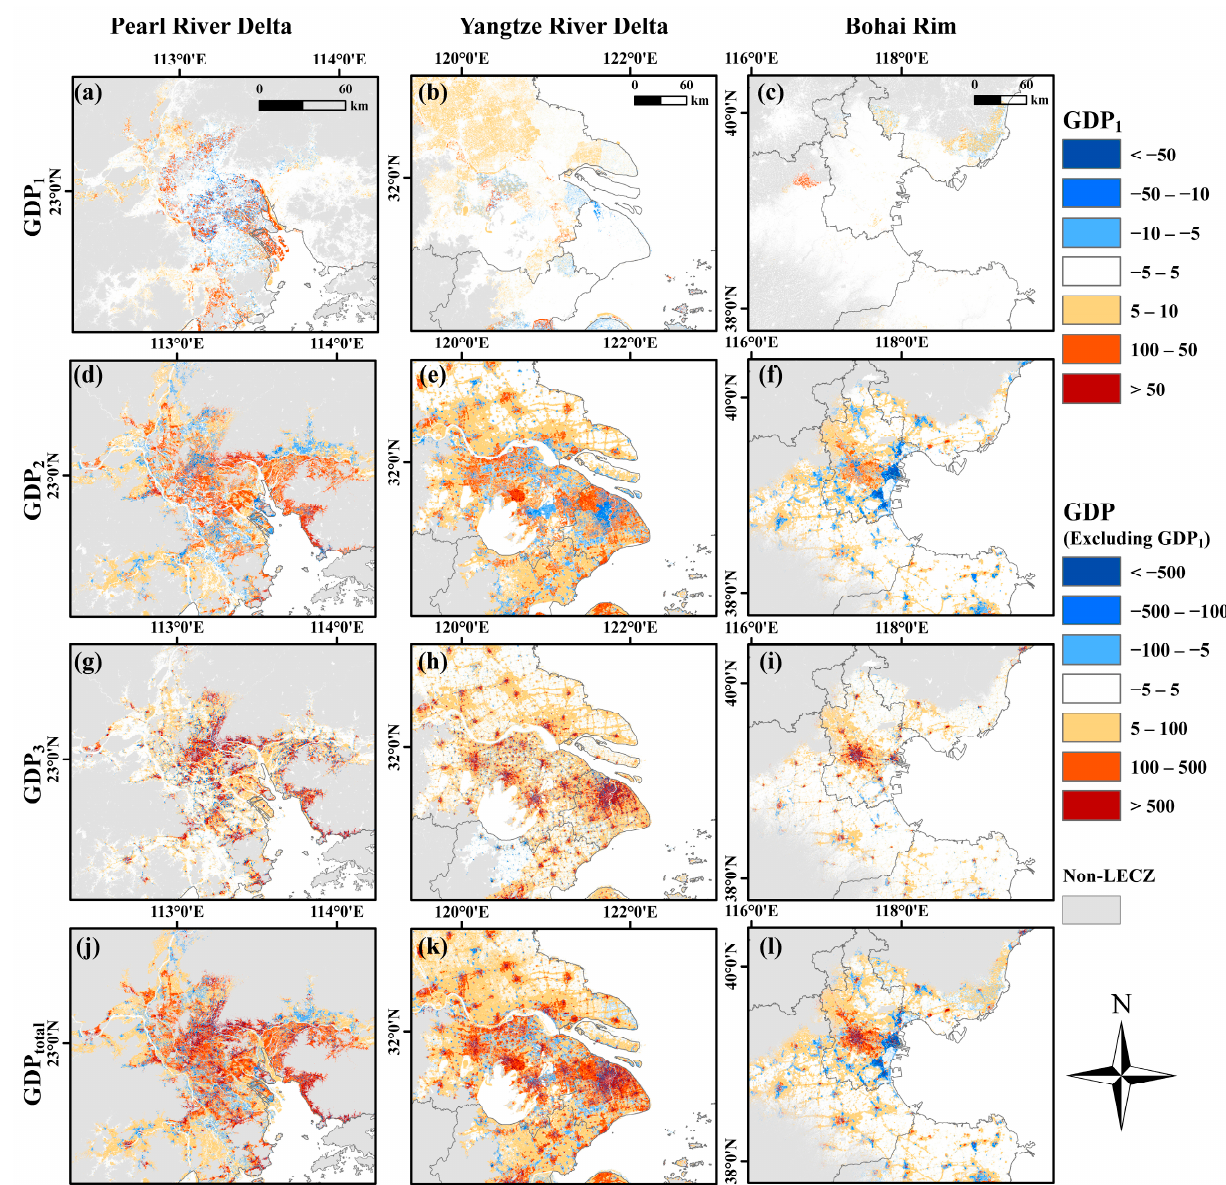
Figure 8. Difference between GDP 1 ( a – c ), GDP 2 ( d – f ), GDP 3 ( g – i ) and GDP total ( j – l ) in 2019 and 2010 for the three economic regions of eastern China (million CNY/ha), with positive values indicating GDP growth and negative values indicating